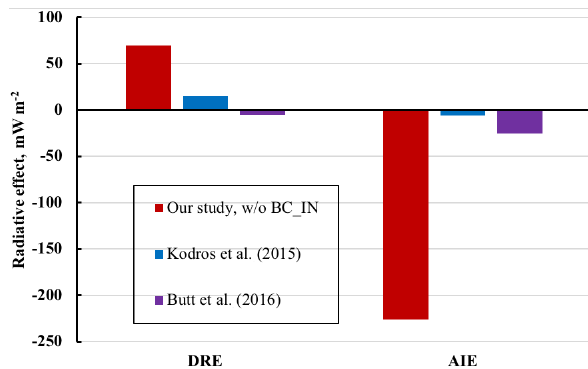
Figure 10. Comparisons of DRE (left) and AIE (right) radiative effects from global solid fuel cookstove emissions in our control simulation with Kodros et al. (2015) and Butt et al.